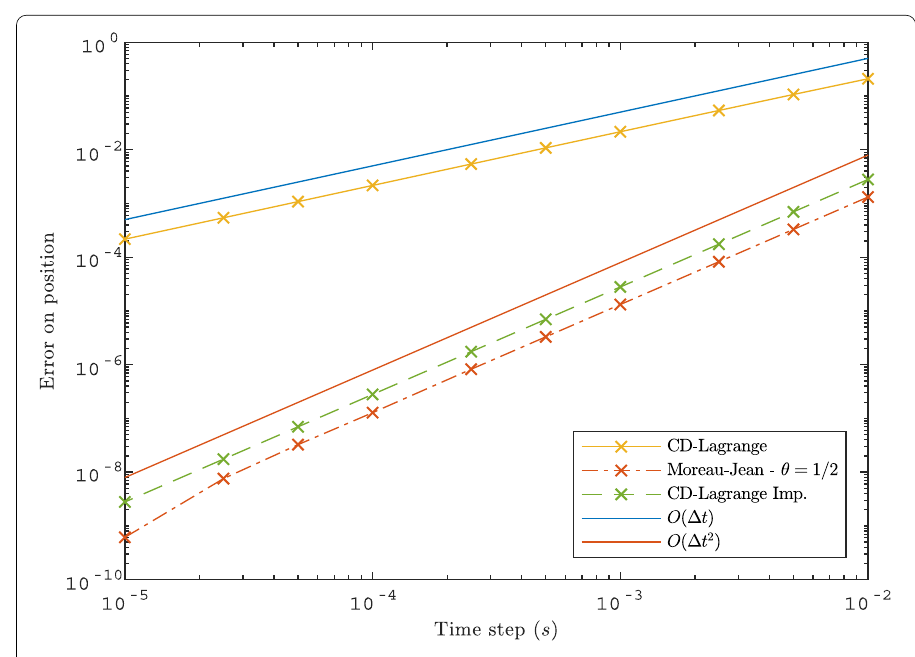
Fig. 12 Van der Pol oscillator—convergence order for position without impact